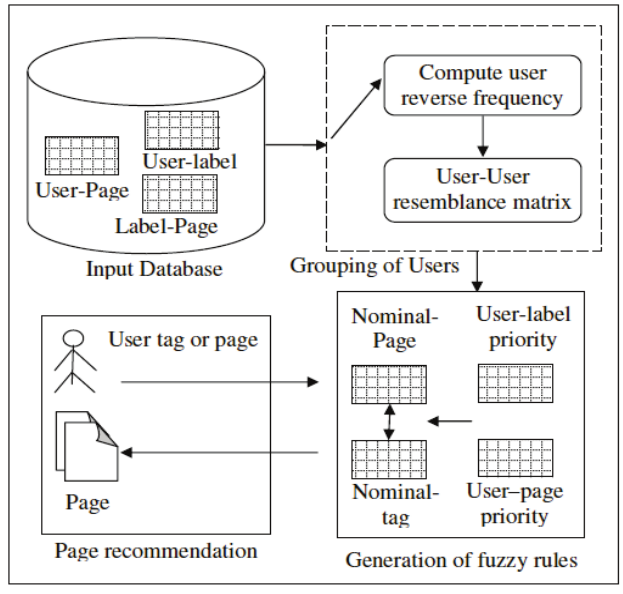
Fig 1. Block diagram of the proposed collaborative tag-based page